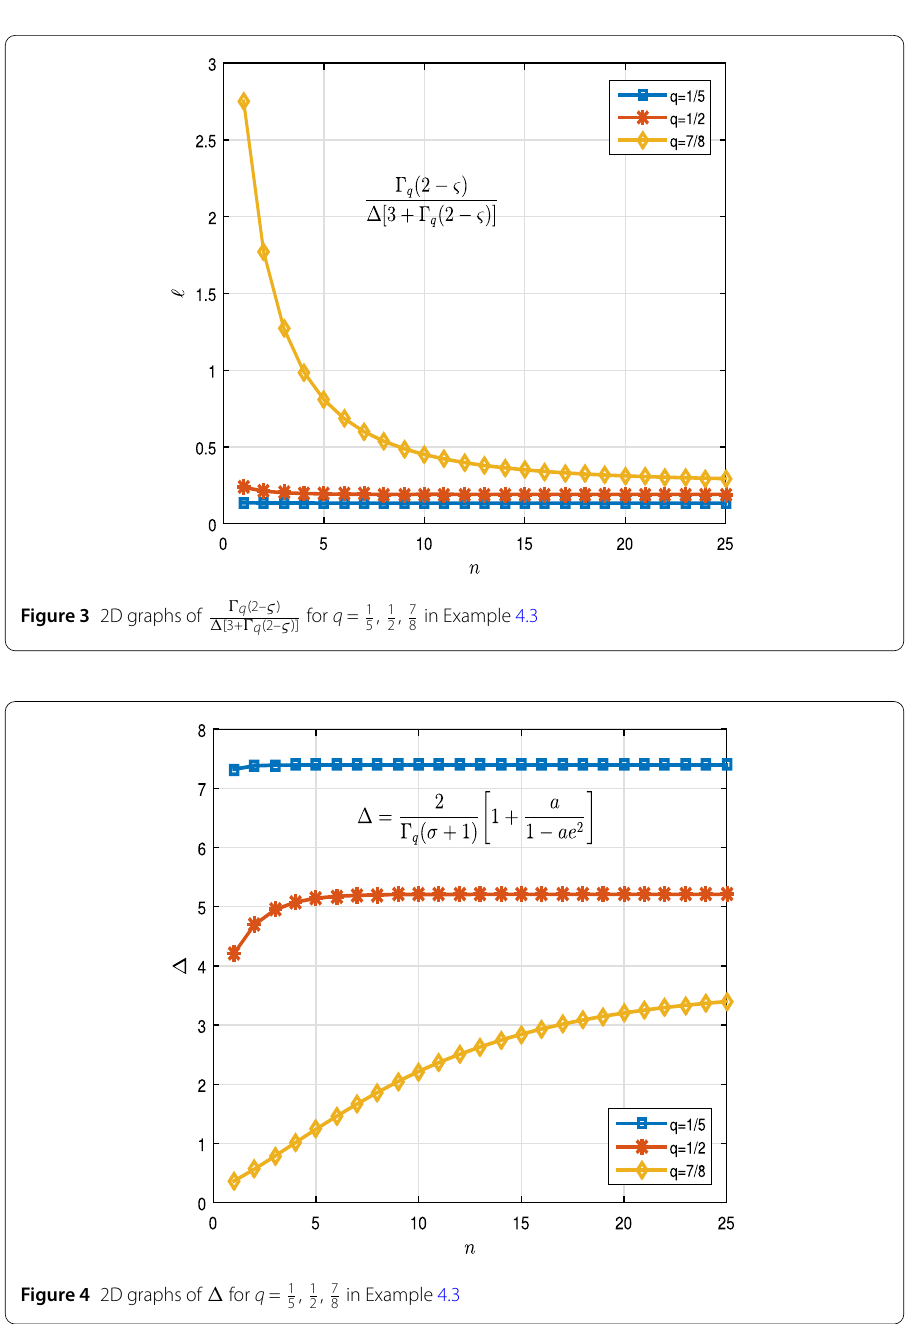
Figure 4 2D graphs of (cid:14) for q = 1